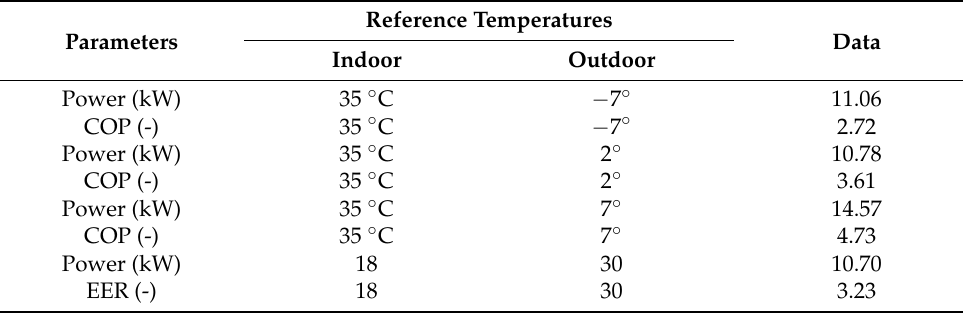
Table 7. Hydronic heat pump: technical data.